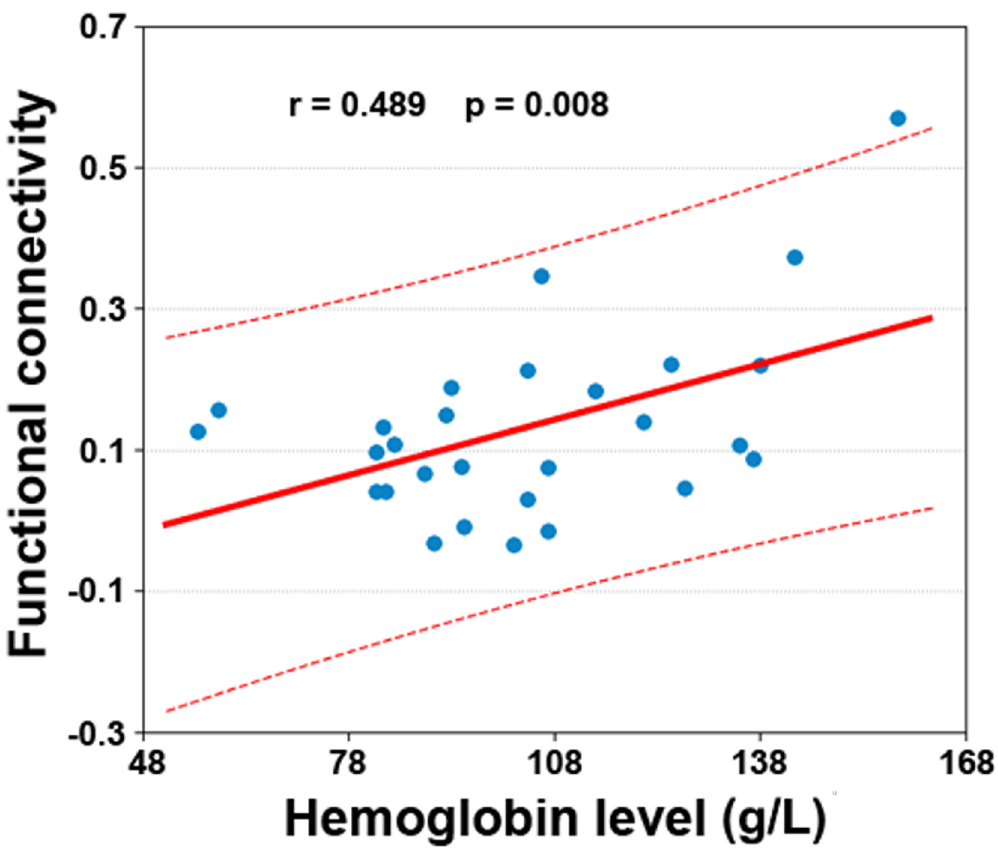
Fig 2. Scatter plot of the relationship between the PCC-right medial superior frontal gyrus functional connectivity and hemoglobin levels in the patients.